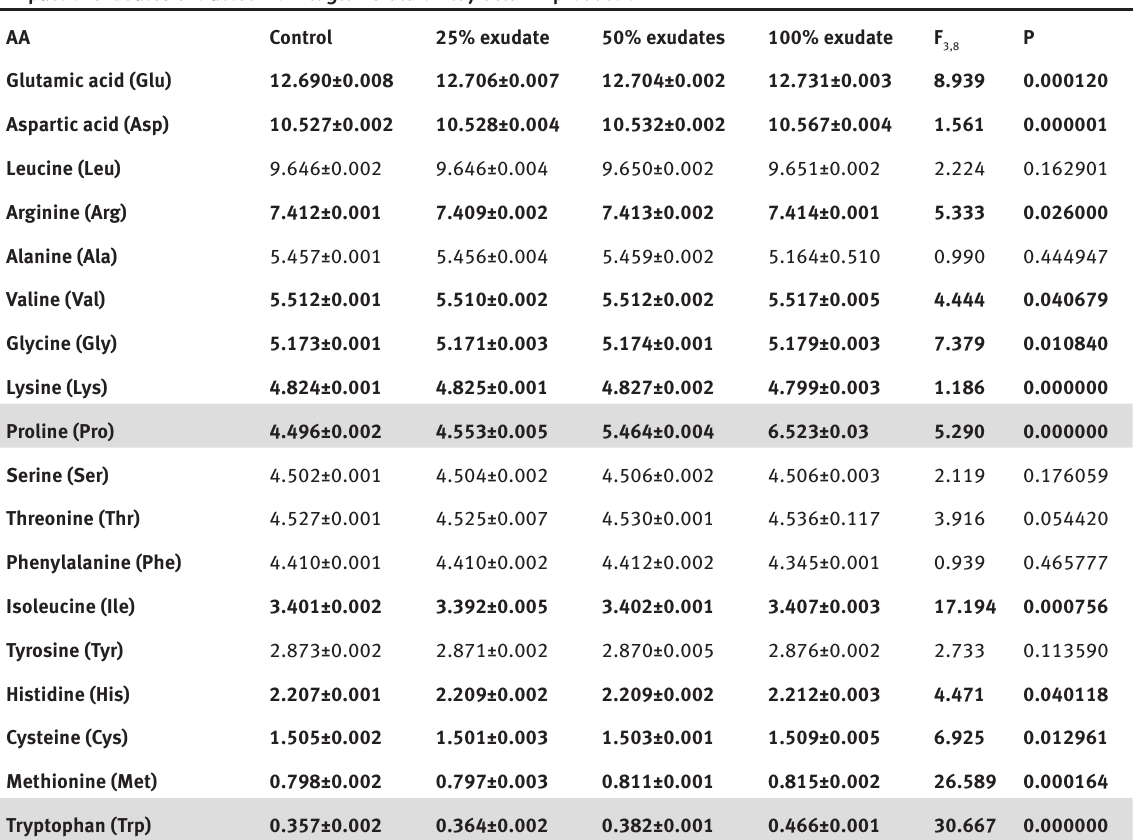
Table 2: The content of amino acids (AA) in Cladophora fracta biomass cultured in medium with exudates from C. glomerata in 3 series (g·100g -1 of total proteins; df=3; bold - statistically significant, P<0.05; gray selection - fluctuation in the content of amino acid > 10%) . Impact of exudates extracted from C. glomerata on C. fracta AA production